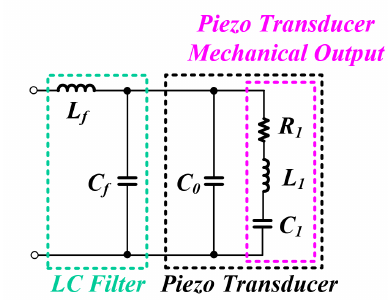
Figure 4. Whole system equivalent model.